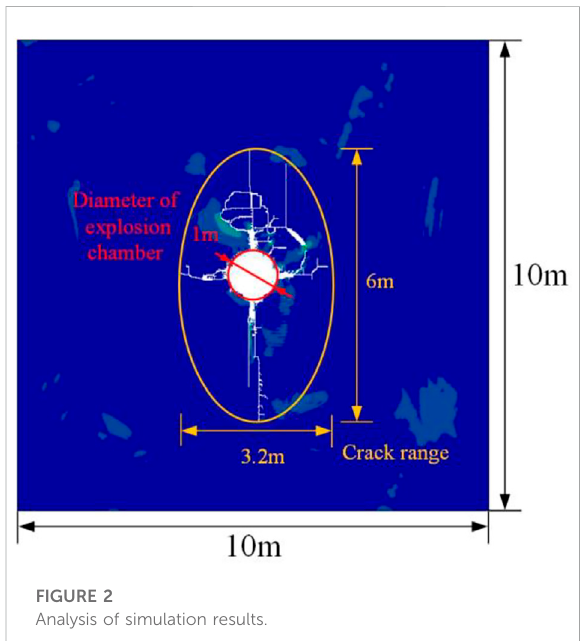
FIGURE 2 Analysis of simulation